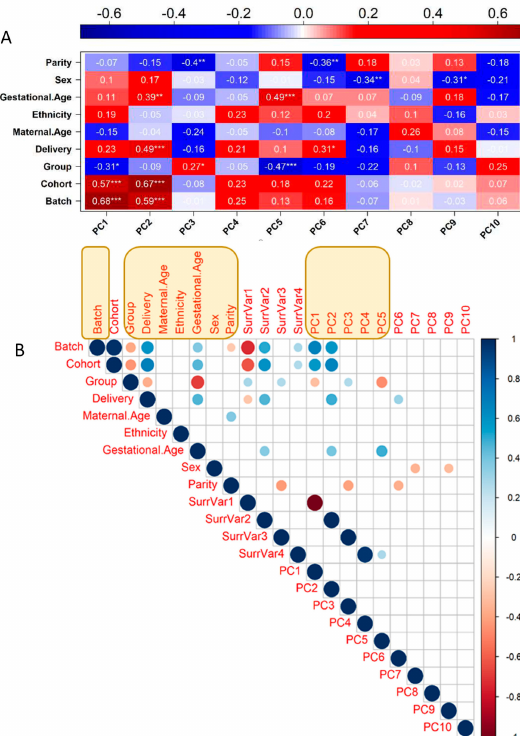
Figure 2. Definition of covariates and surrogate variables potentially affecting the gene expression dataset. ( A ) Eigencorplot expresses the results of Pearson correlation between the clinical and technical variables and the first 10 principal components obtained from the PCA performed on the gene expression dataset. A negative correlation is expressed in blue, and a positive correlation is expressed in red. Within each pair the correlation coefficient is displayed with statistical significance. (* = p -value ≤ 0.05, ** = p -value ≤ 0.01, *** = p -value ≤ 0.001). ( B ) Correlation matrix between the 9 clinical and experimental variables, first 10 PCs of gene expression PCA, and 4 identified surrogate variables, having effects on global transcriptomic changes. Only statistically significant correlations ( p -value ≤ 0.05) are displayed as dots of increasing size as a measure of the correlation coefficient. Positive correlations are displayed in blue, and negative correlations are displayed in red. In yellow boxes are the variables that were kept as covariables for subtracting their effect (see